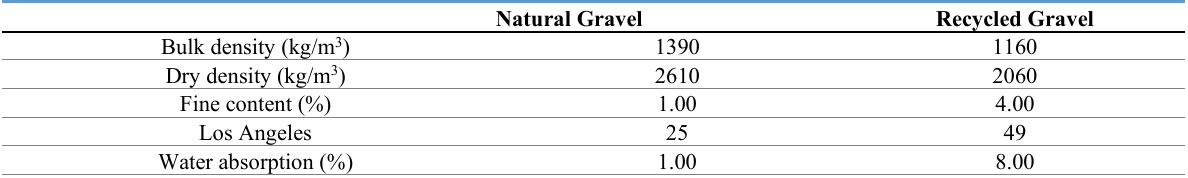
Table 5. Coarse aggregates characteristics.